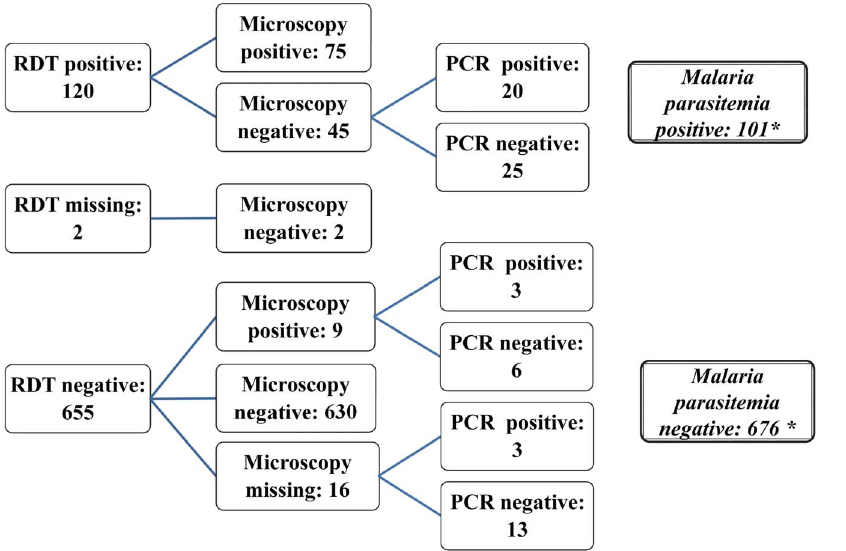
Figure 3. Total Number of Participants with and without Malaria Parasitemia based on Laboratory (RDT, Microscopy and PCR) Results. *Malaria parasitemia positive was defined as either concordant RDT and microscopy positive (75) or PCR positive (26) for discordant results. Malaria parasitemia negative was defined as either microscopy negative without discordance (632) or PCR negative (44) for discordant results. doi:10.1371/journal.pone.0094074.g003 PLOS ONE |